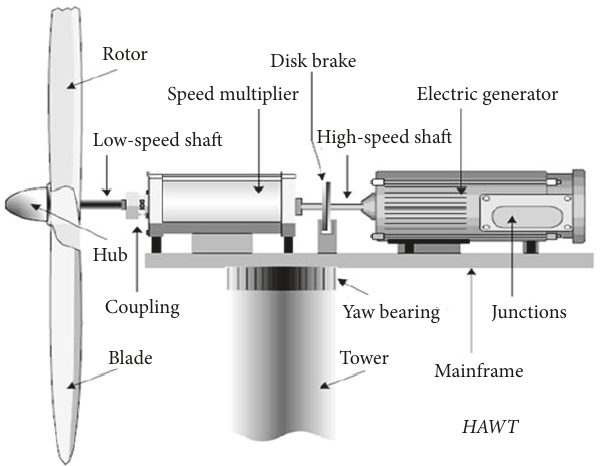
Figure 1: The composition of a wind turbine